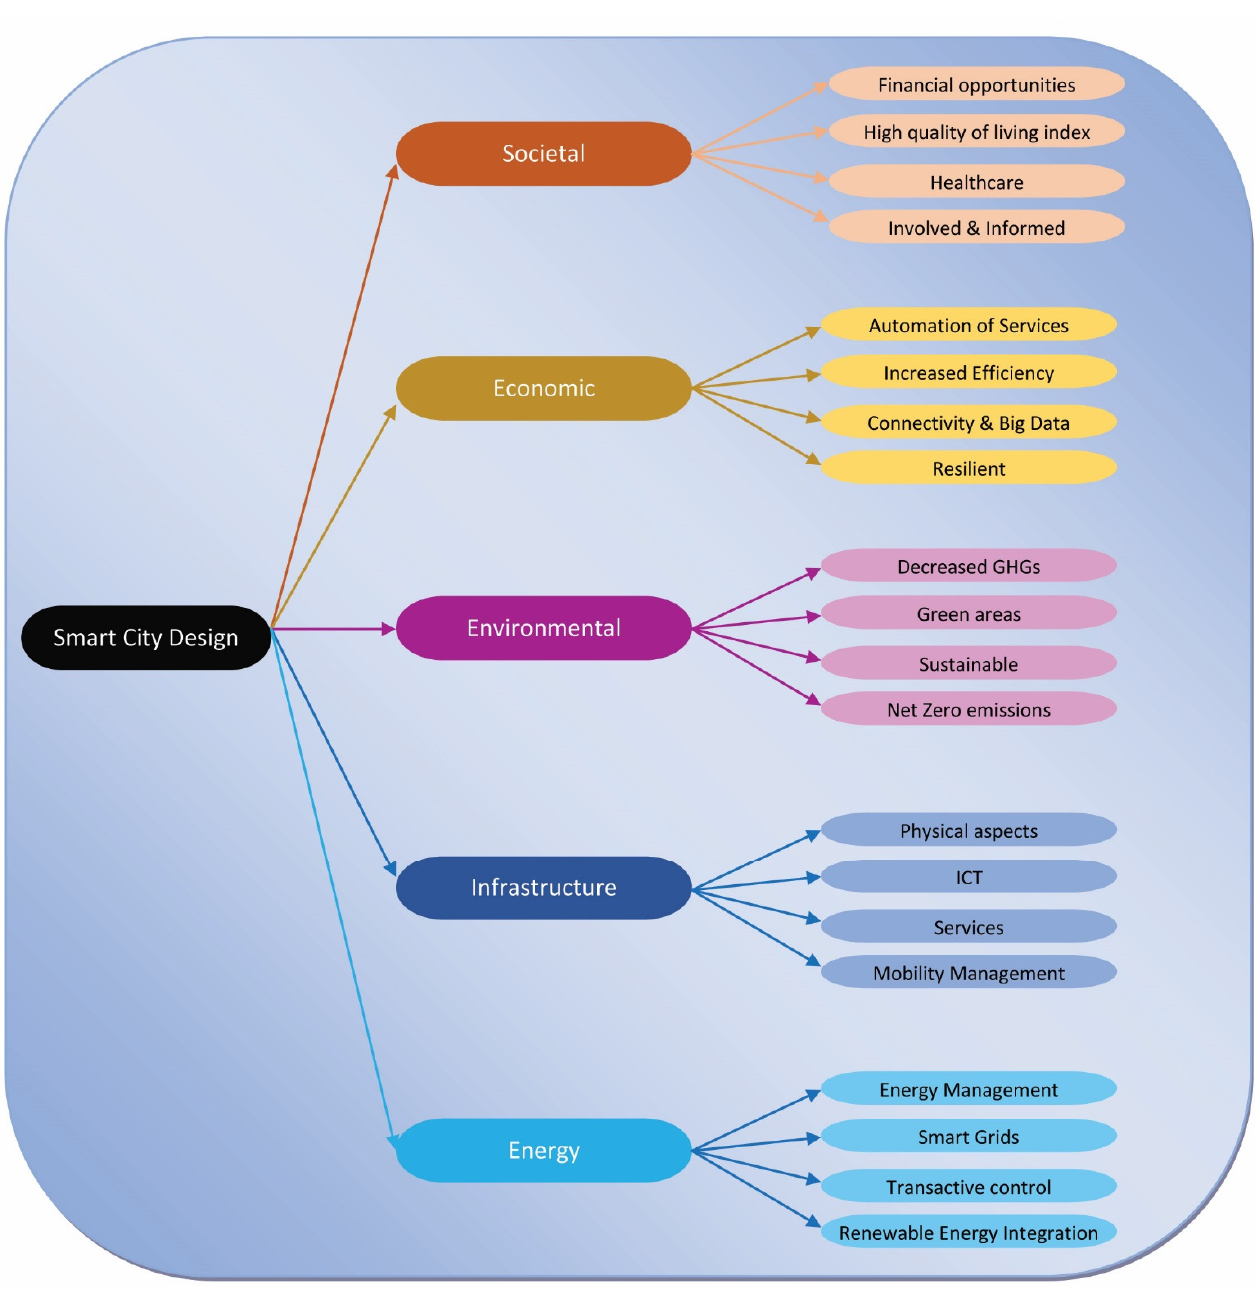
Figure 7. Proposed five pillars of smart city design.